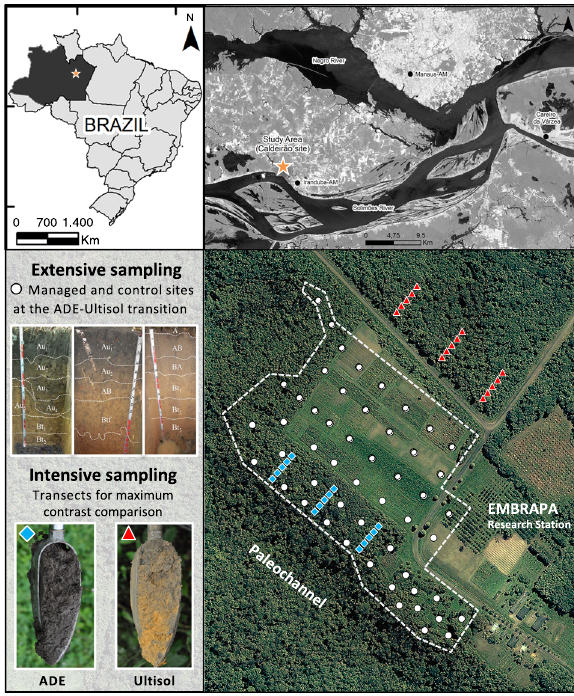
Fig. 1 Experimental station in Iranduba, Amazonas, Brazil. Photos depict typical soil pro fi les previously described as sandy clay loam ADEs and very clayey Ultisols (left to right: ADE Orthodystric; ADE Lixic, Orthoeutric; and Ultisol Hyperdystric), images adapted from ref. 5 . Auger photos depict the difference in colouration caused by differences in pyrogenic carbon content measured here. White circles indicate reference soil pro fi les used to generate a site-wide spatial analysis of extractable phosphorus (P) and calcium (Ca) using data from EMBRAPA-CPAA archives, shown in Fig. 2. Interpolation maps of extractable P and Ca were used to select replicated transects for maximum contrast comparison of total stocks of P and Ca in ADE (blue diamonds) and Ultisol (red triangles) pro fi les, shown in Fig. 3, and other mineral elements shown in Supplementary